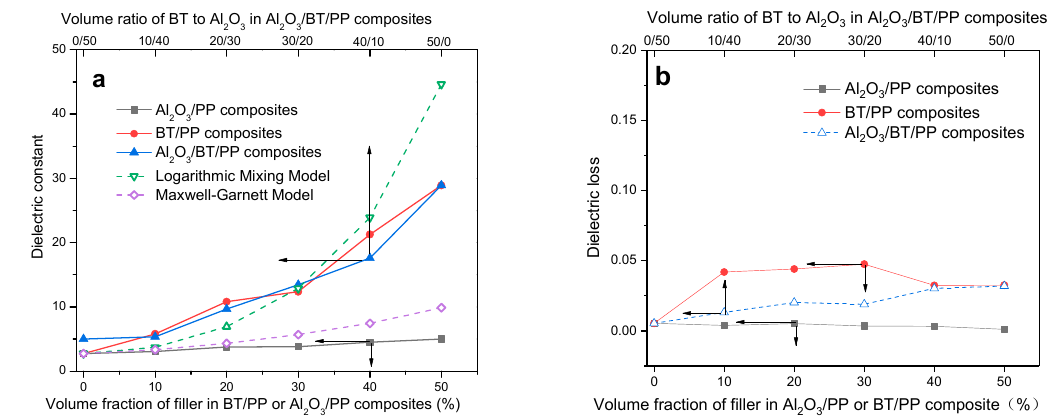
Figure 6. Dielectric properties of Al 2 O 3 /BT/PP, Al 2 O 3 /PP and BT/PP composites with different f filler @ 1000 Hz: ( a ) dielectric constant of the composites; ( b ) dielectric loss of the composites.